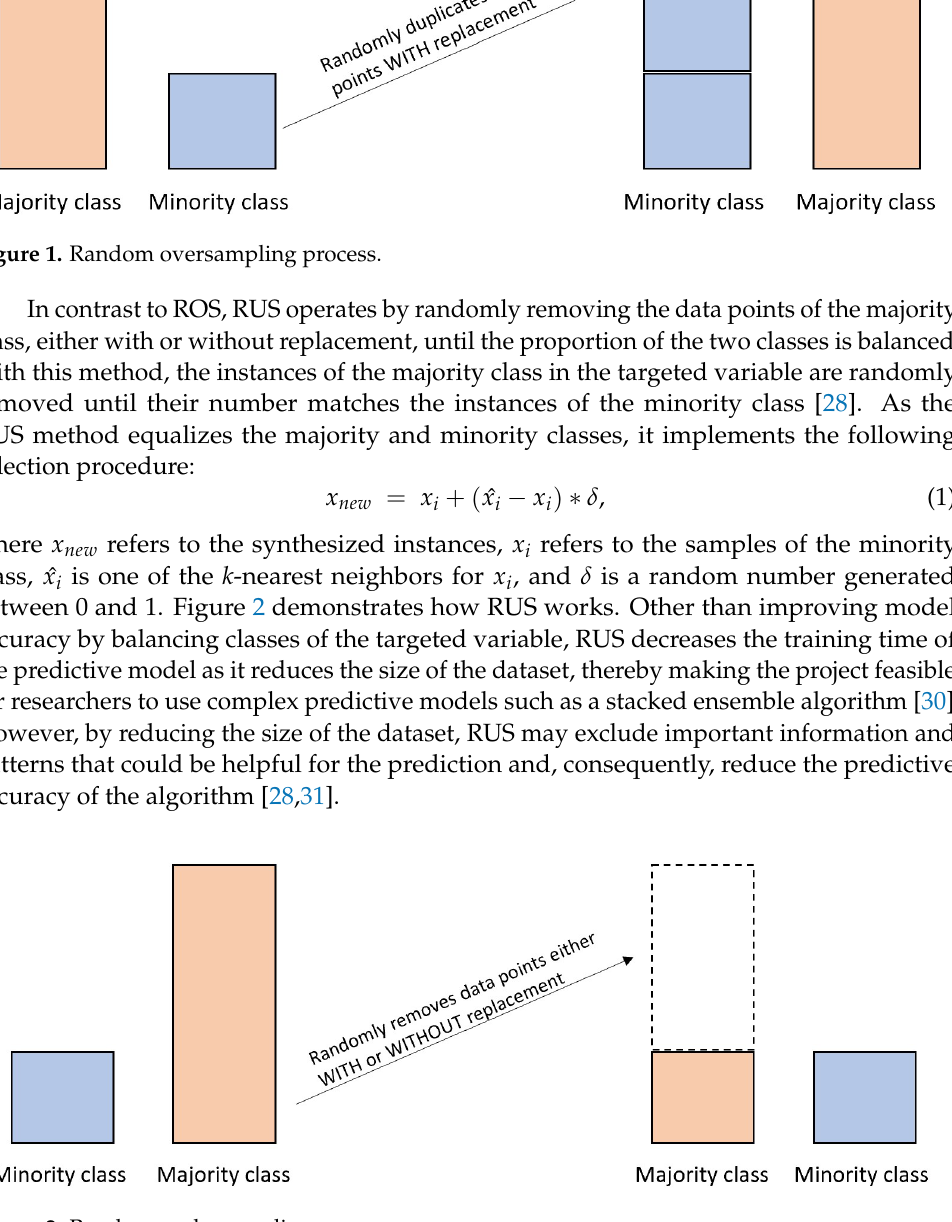
Figure 2. Random undersampling